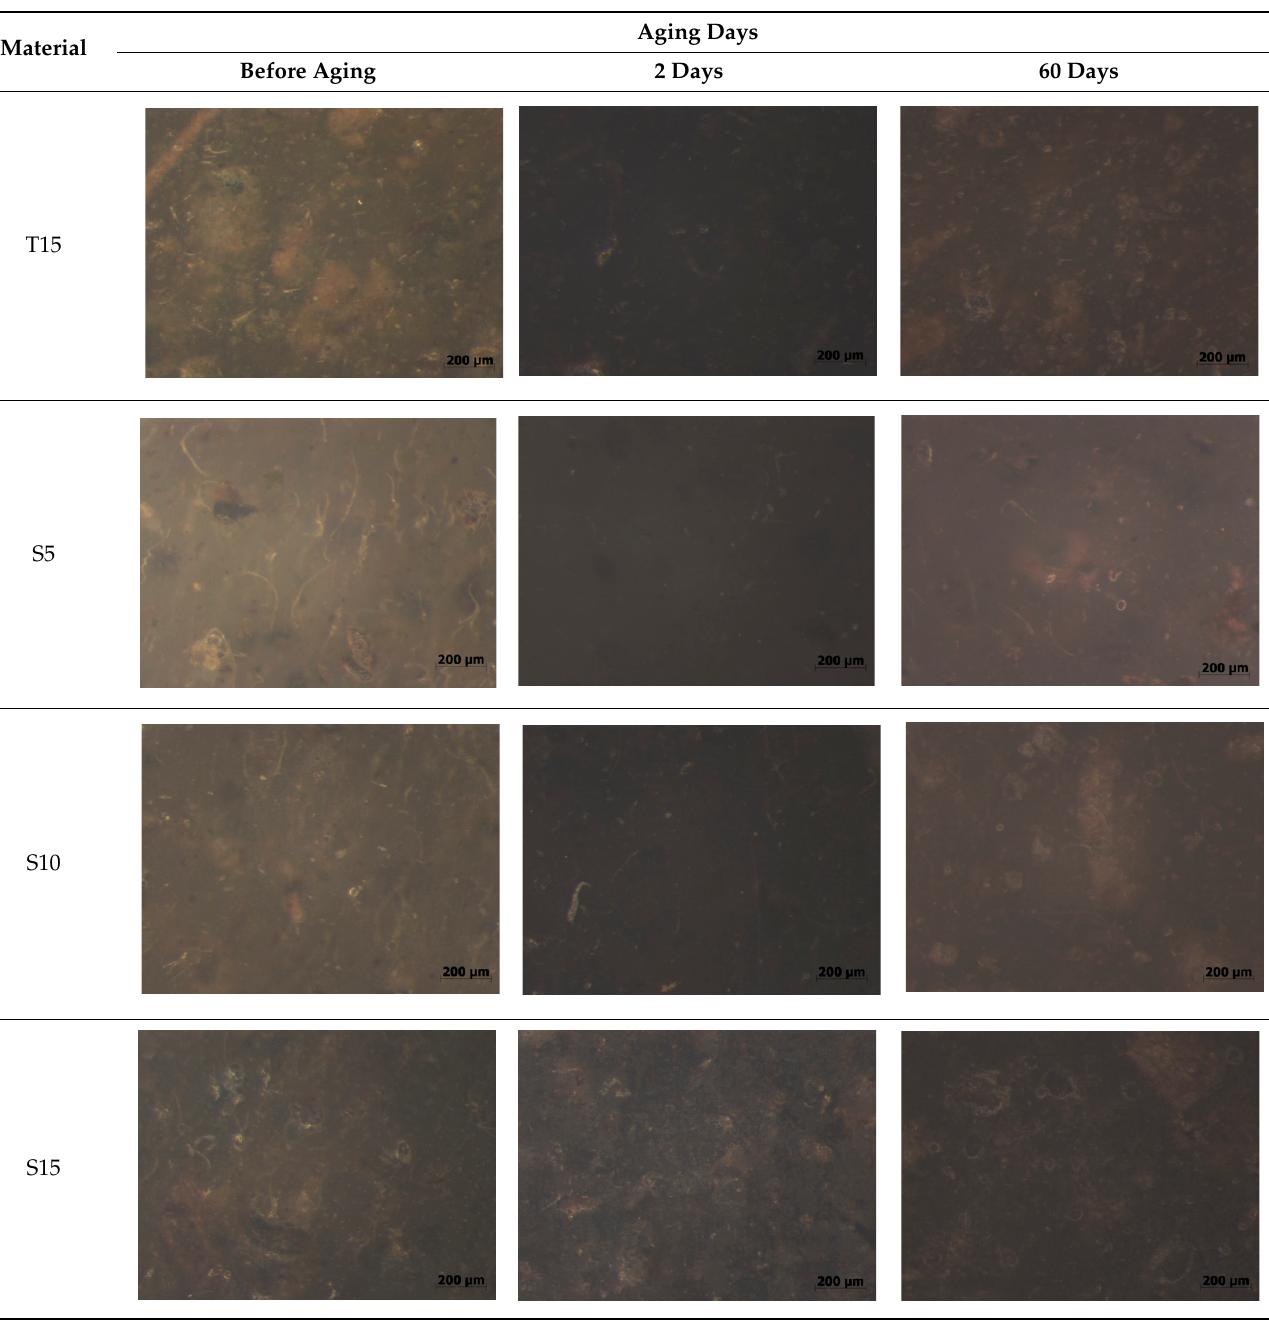
Figure 11. IR spectra of reference material: black—before aging, red—2 days of aging, blue—60 days of aging. All samples exhibited peaks corresponding to Si-O-Si, CH 3 rocking and bending in Si-CH 3 , and C-H stretching in CH 3 bands characteristic of PDMS [51]. The reference mate- rial spectrum remained almost intact after 2 and 60 days of degradation. The peaks corre- sponding to Si(CH 3 ) 2 stretching and Si-O-Si stretching are of higher intensity for aged samples (Figure S1, supplementary materials).